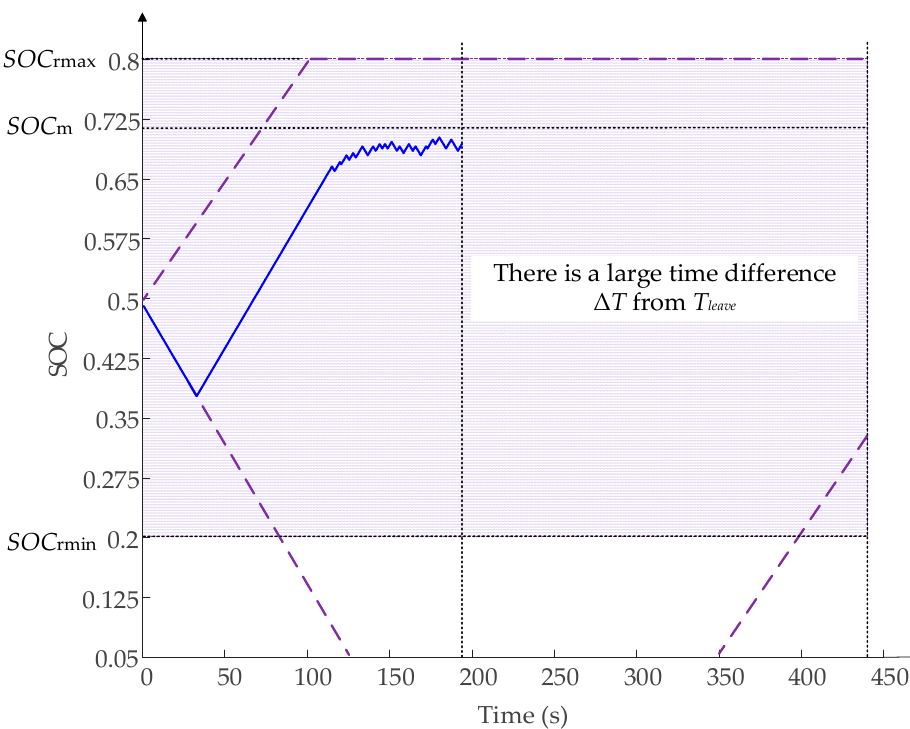
Figure 11. Changes of SOC of EVs in the normal range.